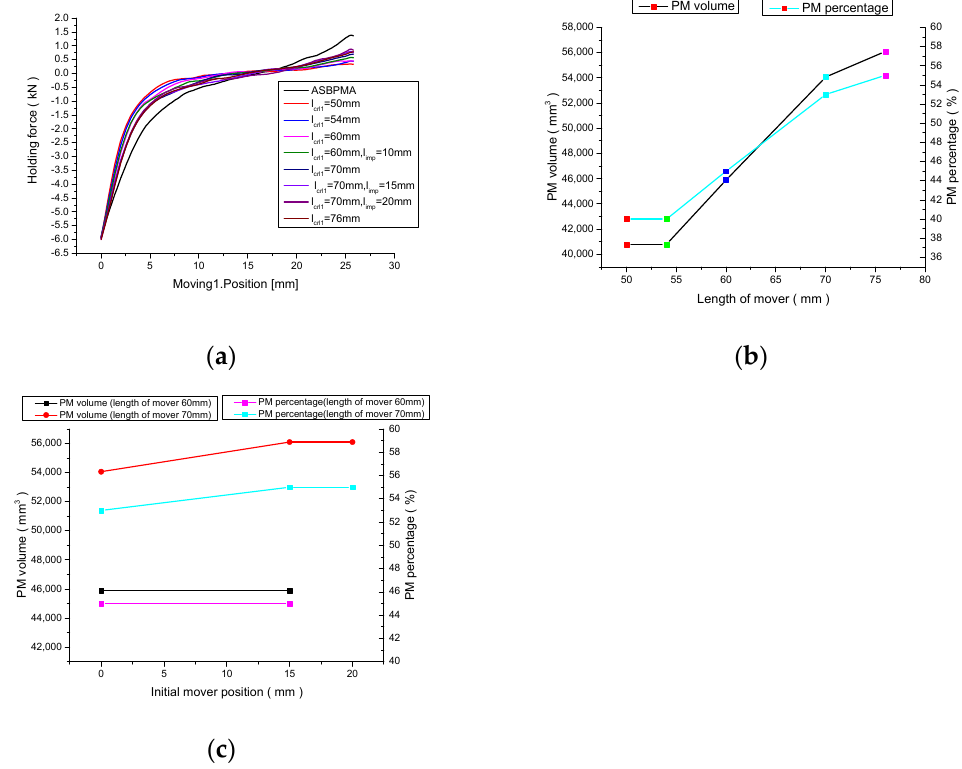
Figure 5. The characteristics curve of the presented ABSMPMA. ( a ) The characteristic of the moving position vs. retaining force. ( b ) The characteristic of the length of mover vs. PM volume. ( c ) The characteristic of the initial mover position vs. PM